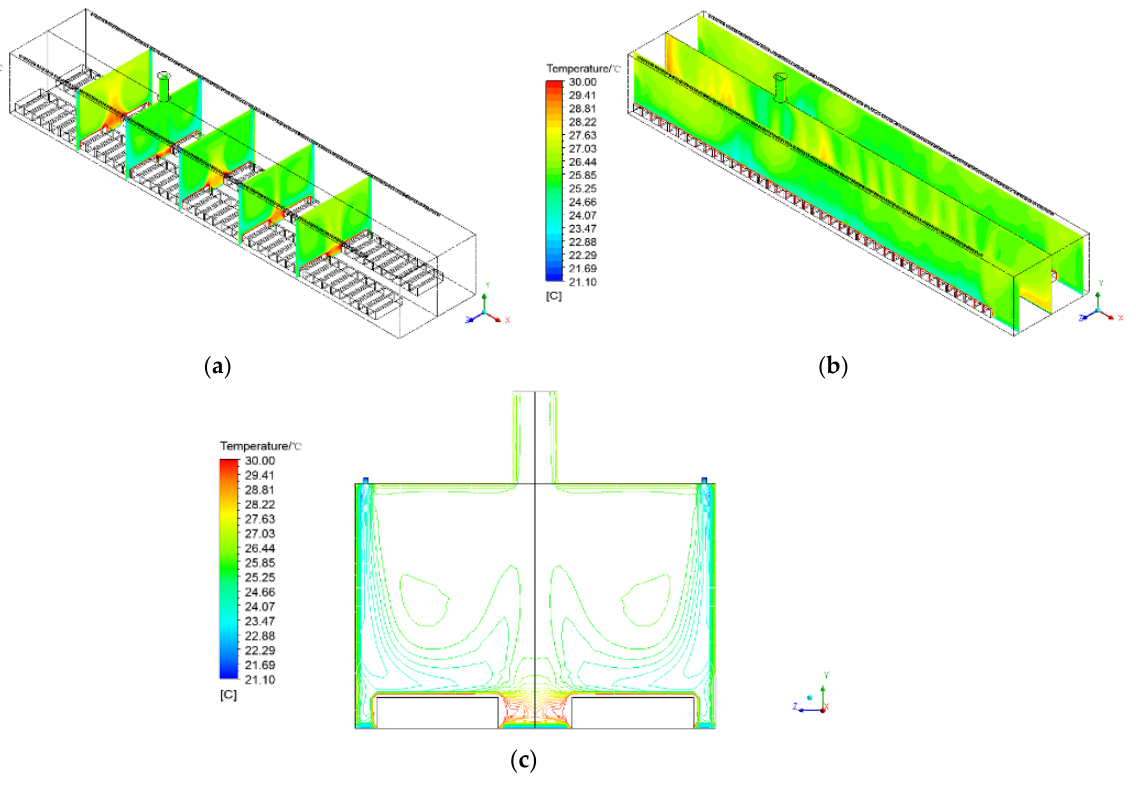
Figure 6. Temperature distribution in different ( a ) longitudinal and ( b ) horizontal sections; ( c ) tem- perature gradient variation in different horizontal sections.